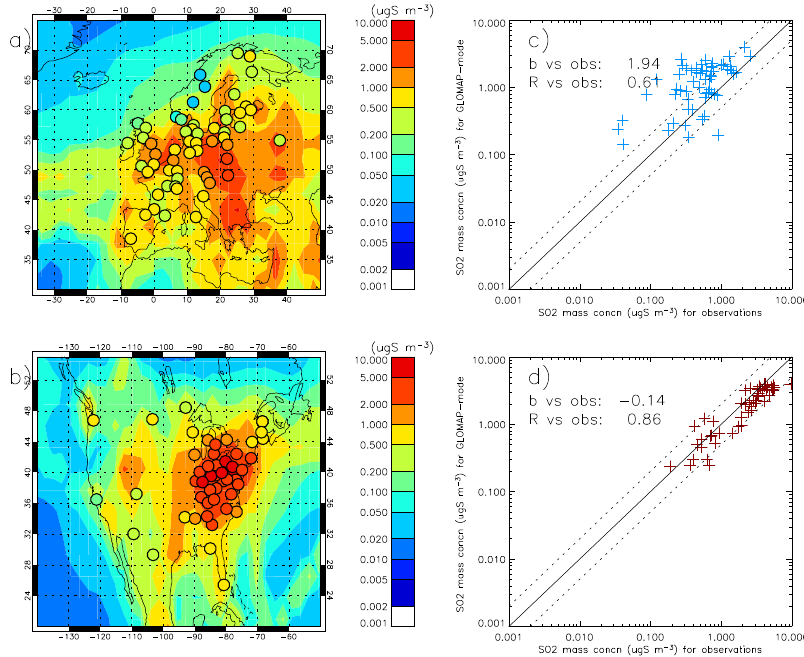
Fig. 3. Maps of simulated annual-mean SO 2 concentration in the lowest model level over (a) Europe and (b) North America with year- 2000 surface observations from sites in the EMEP and IMPROVE networks respectively over-plotted. Scatter plots for the model (y-axis) compared to the observations (x-axis) are shown in panels (c) and (d) with b and R values for each region. Observations are for the year 2000 with only sites where the height above sea-level is within 250m of that calculated for the lowest model level included.